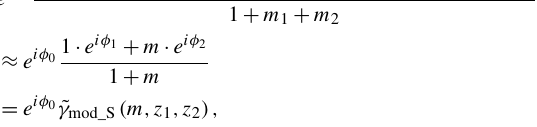
/h v of the obtained ice volume h v for the proposed model. h /h v = 25% or σ δ /h v = h h